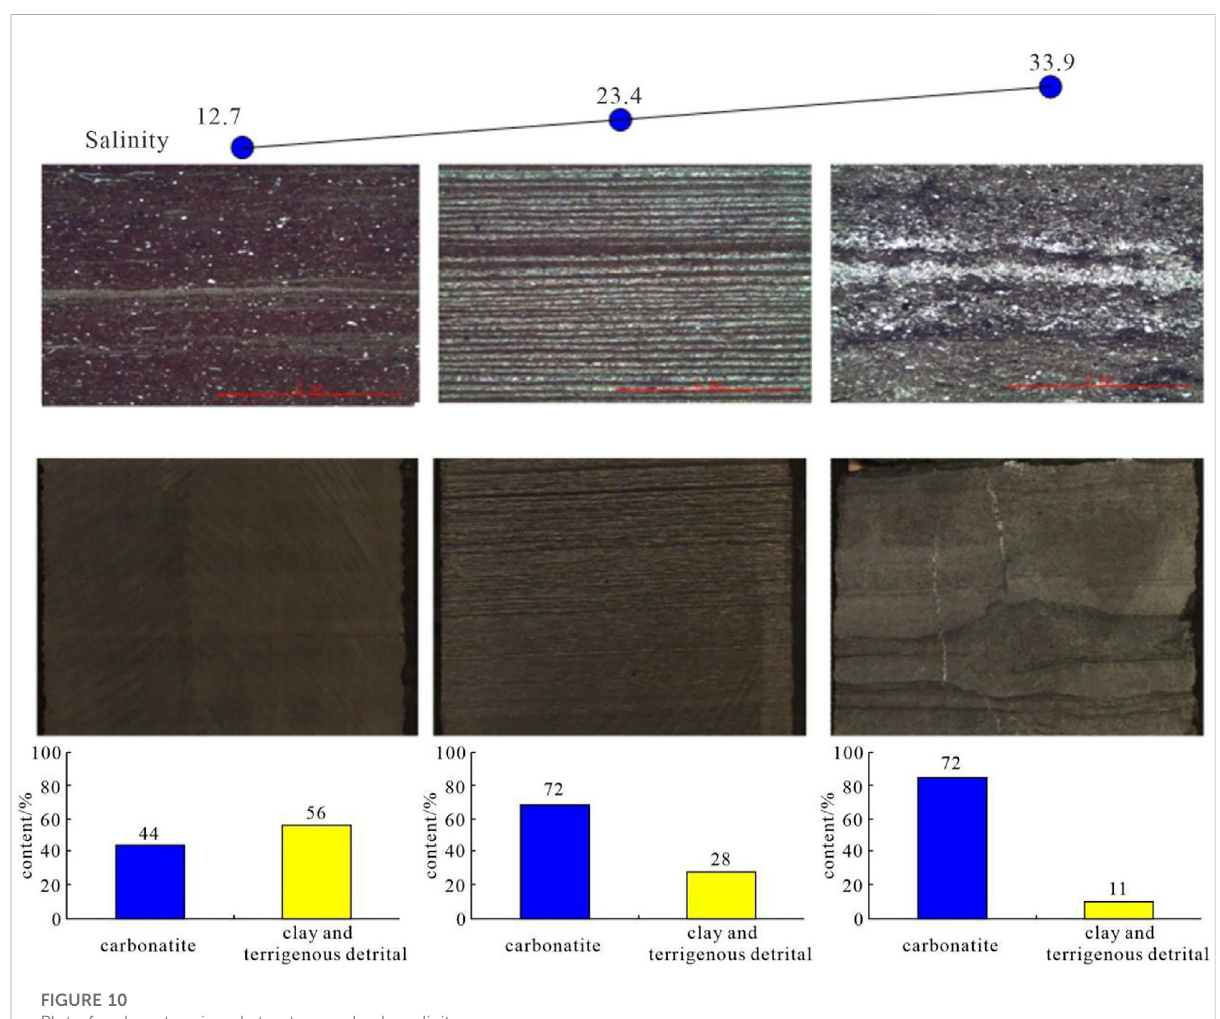
FIGURE 10 Plot of carbonate mineral structure and